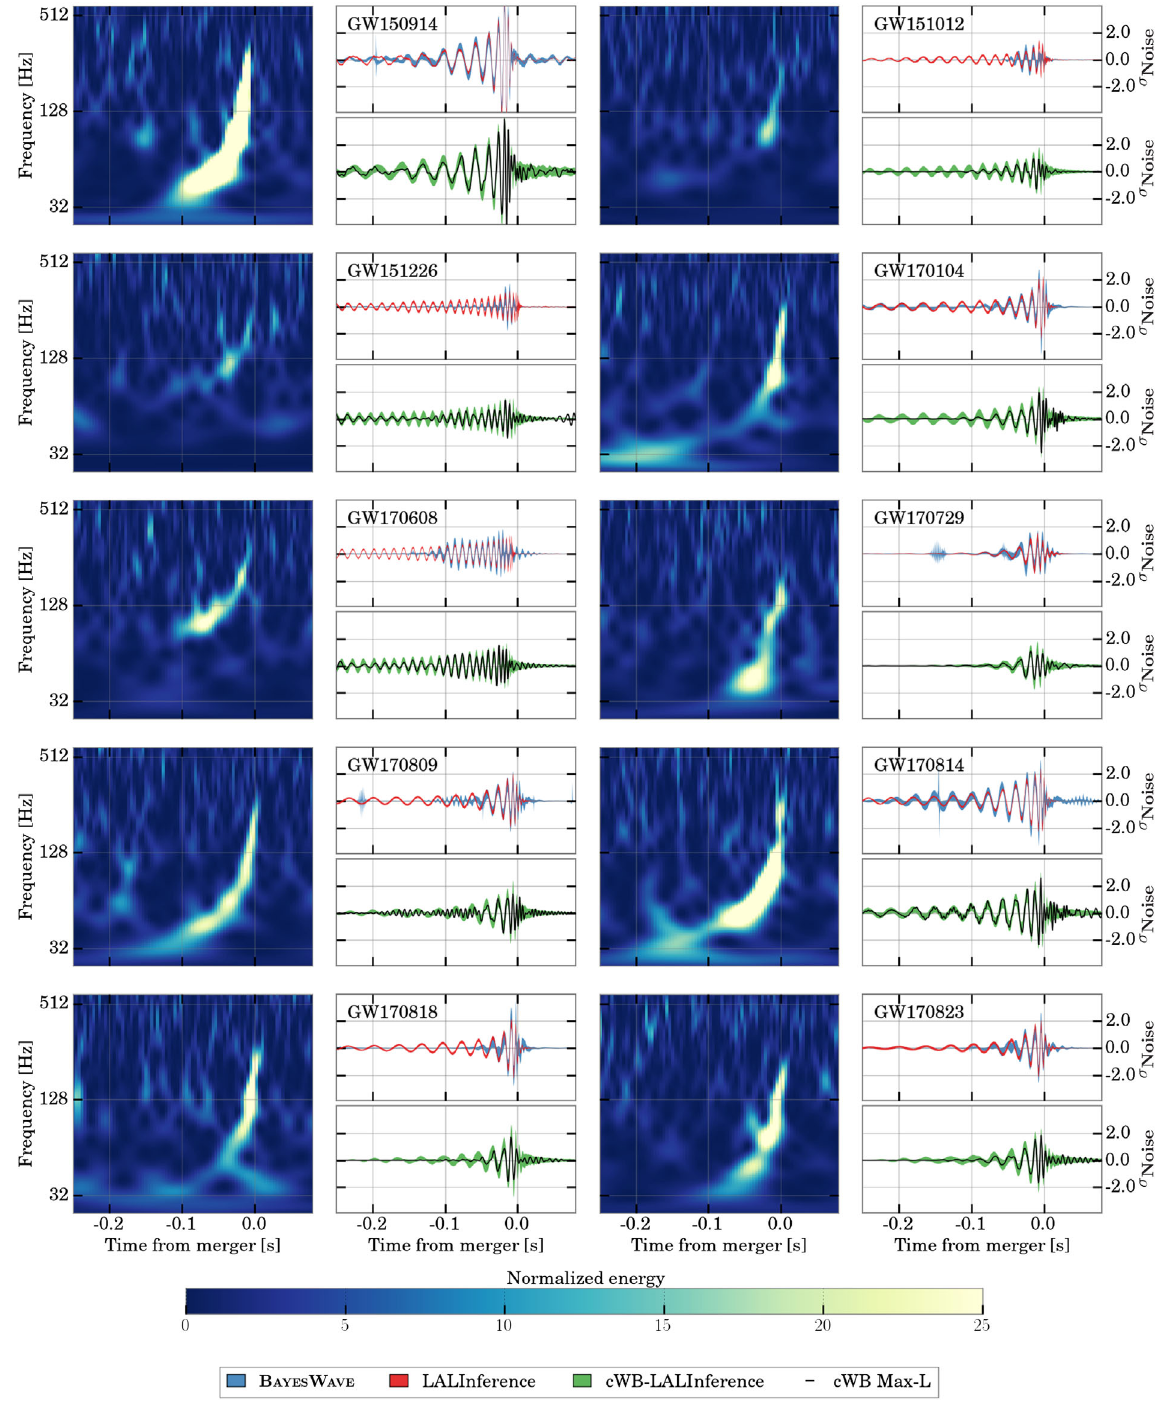
FIG. 10. Time-frequency maps and reconstructed signal waveforms for the ten BBH events. Each event is represented with three panels showing whitened data from the LIGO detector where the higher SNR is recorded. The first panel shows a normalized time- frequency power map of the GW strain. The remaining pair of panels shows time-domain reconstructions of the whitened signal, in units of the standard deviation of the noise. The upper panels show the 90% credible intervals from the posterior probability density functions of the waveform time series, inferred using CBC waveform templates from Bayesian inference (LALI NFERENCE ) with the PhenomP model (red band) and by the B AYES W AVE wavelet model (blue band) [53]. The lower panels show the point estimates from the cWB search (solid lines), along with a 90% confidence interval (green band) derived from cWB analyses of simulated waveforms from the LALI NFERENCE CBC parameter estimation injected into data near each event. Visible differences between the different reconstruction methods are verified to be consistent with a noise origin (see the text for